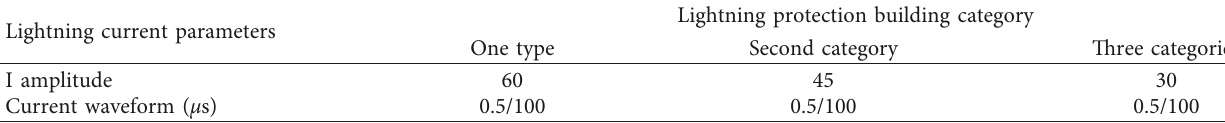
Table 2: Amplitude of lightning current after the first lightning strike.